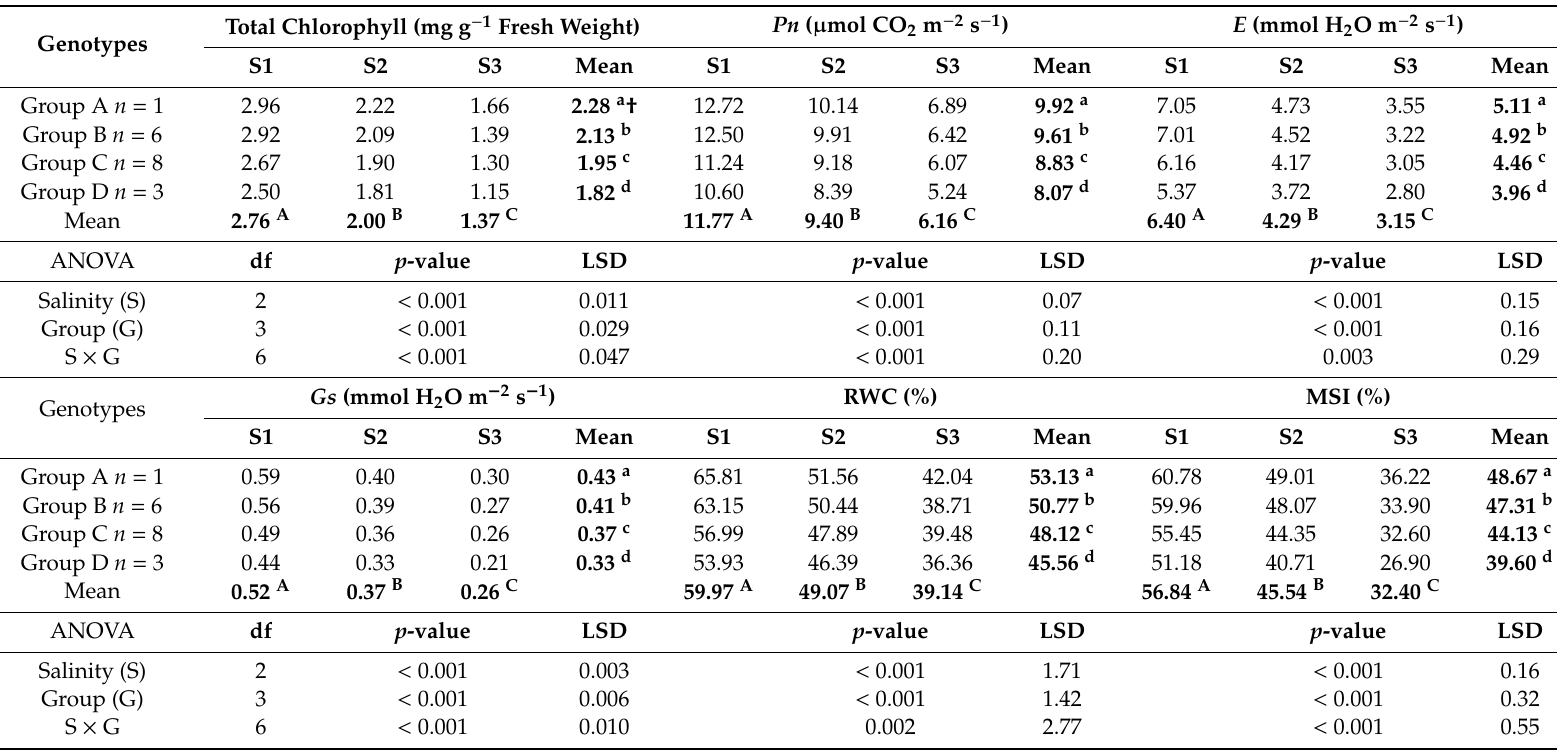
Table 2. Impact of di ff erent salinity levels on total chlorophyll concentration, net photosynthetic rate ( Pn ), transpiration rate ( E ), stomatal conductance ( Gs ), relative water content (RWC), and membrane stability index (MSI) of four genotype groups classified according to salinity tolerance under three salinity levels of